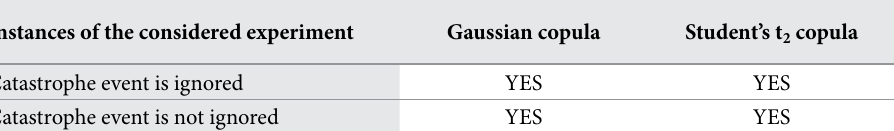
Table 3. The considered cases for the